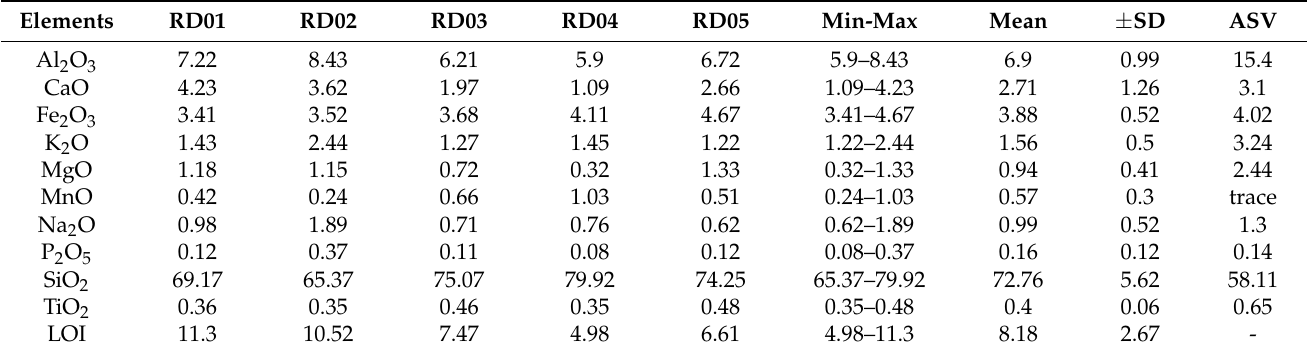
Table 3. Composition of major elements in road dust samples (Wt.